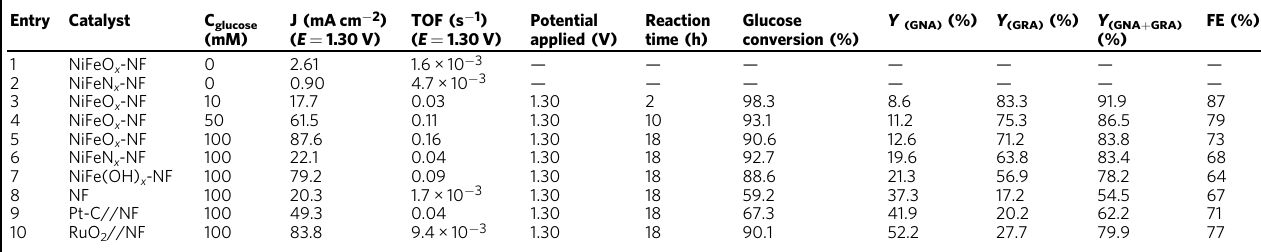
Table 1 Electrochemical anodic glucose oxidation and OER in 1 M